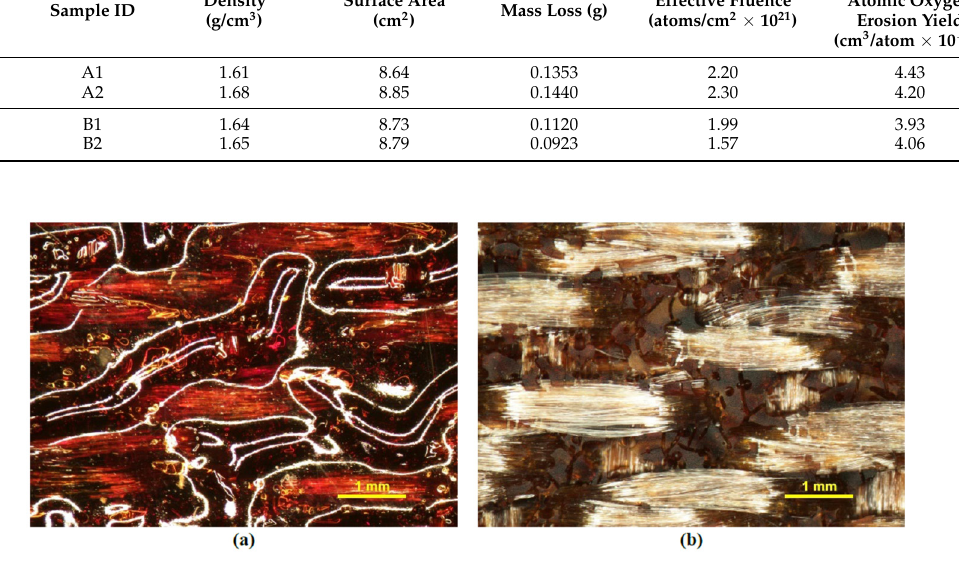
Figure 9. Optical microscopy images comparing Nextel 312/poly(BAF-oda-fu) composite surface features ( a ) before and ( b ) after ground-based atomic-oxygen erosion testing.